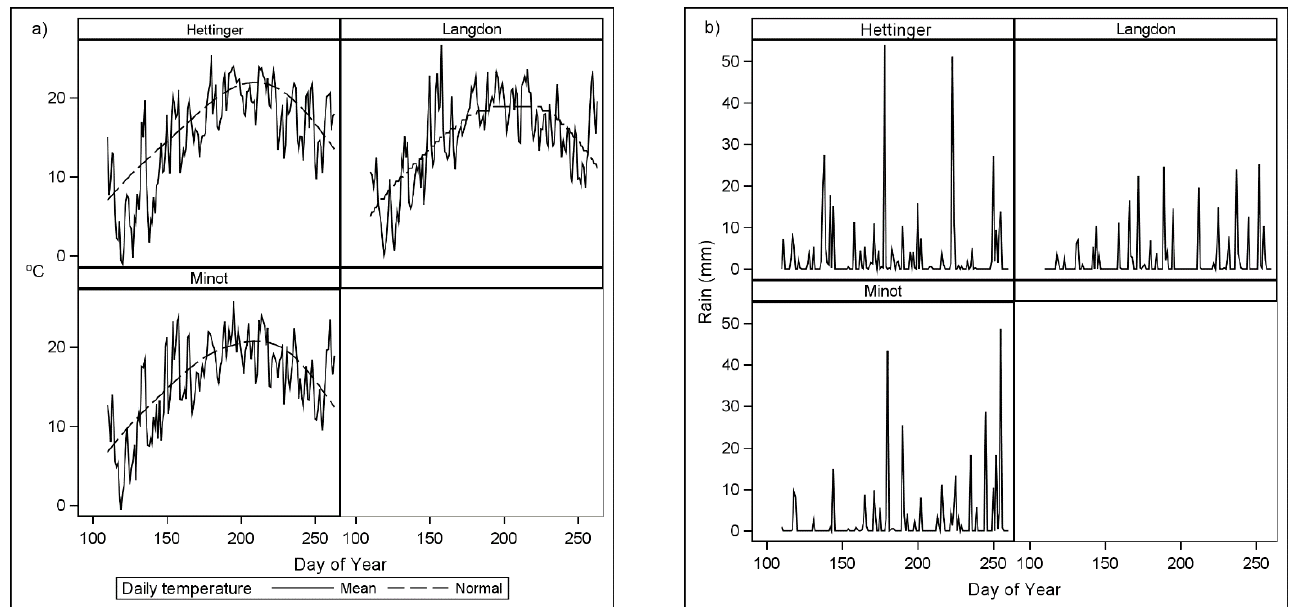
Figure 1. Wheat growing season ( a ) daily mean and normal temperatures and ( b ) daily rainfall in 2019 where day of year 100 is 10 April.